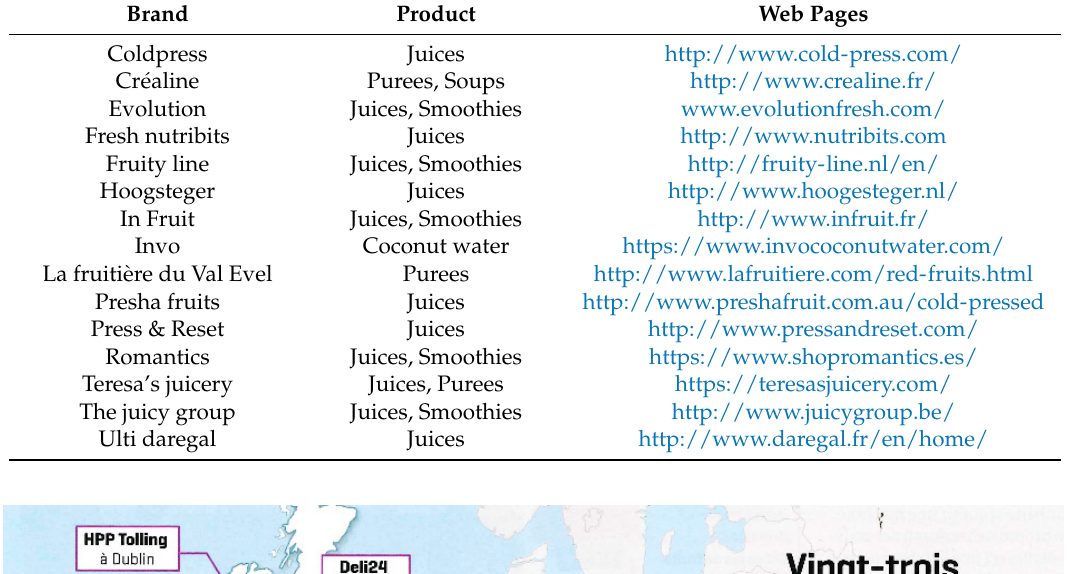
Table 1. Brands, webpages and fruit/vegetable products treated by HPP in the European Union (EU) market.